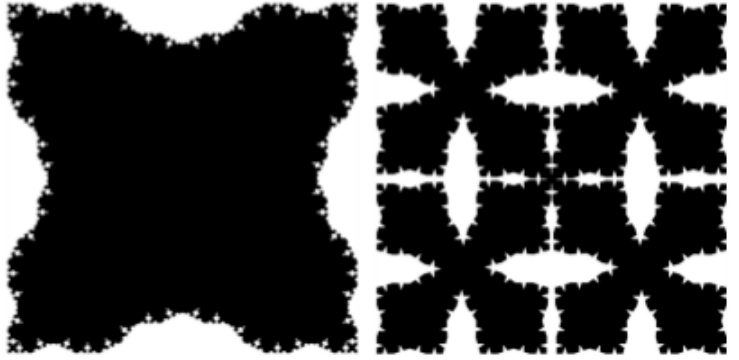
Figure 2. Koch curves inside the square. We have the Dirichlet condition on the boundary ∂ E . The domains are non-trap for the Brownian